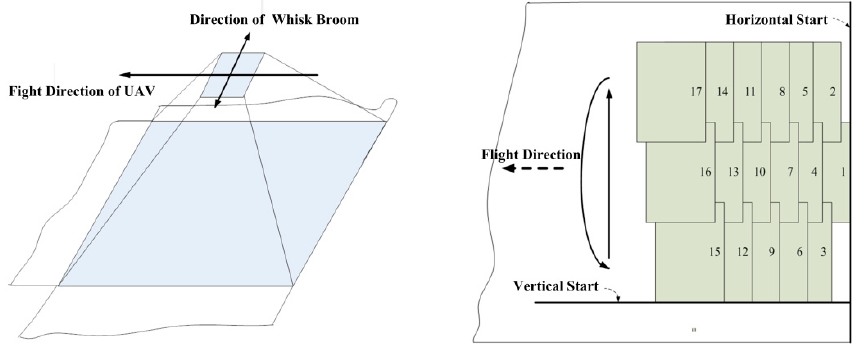
Figure 10. Obtaining remote sensing image set.